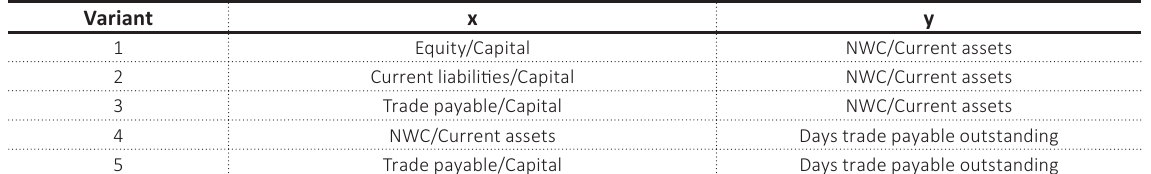
Table 1. Variables for the correlation